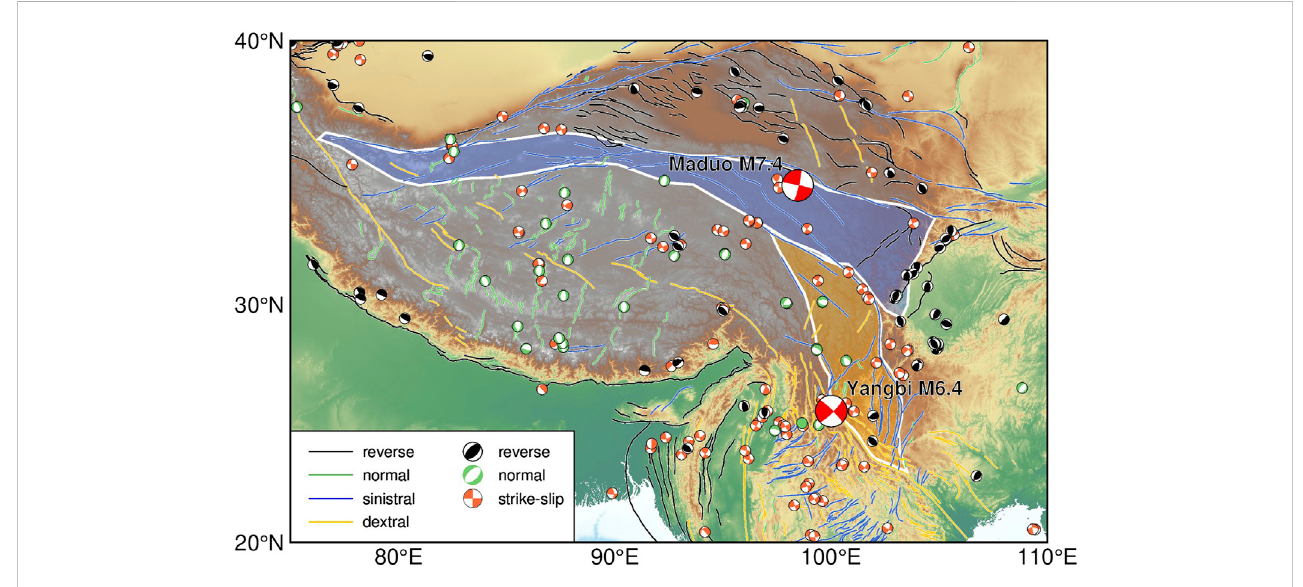
FIGURE 1 Map showing active faults (lines) and moderate to large earthquakes (beach balls) on the Tibetan Plateau, with their kinematic types coded by colors. Geological blocks fi lled with blue and yellow are the Bayan Har and Chuandian blocks, respectively. Locations and focal mechanisms of the 2021 May Yangbi and Maduo earthquakes are indicated by red beach